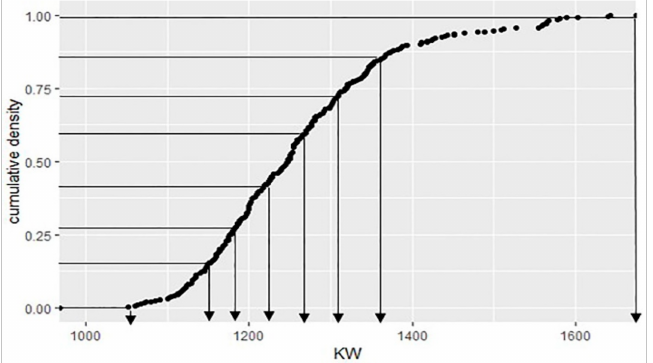
Figure 6. Selection of the initial centroid using the percentile